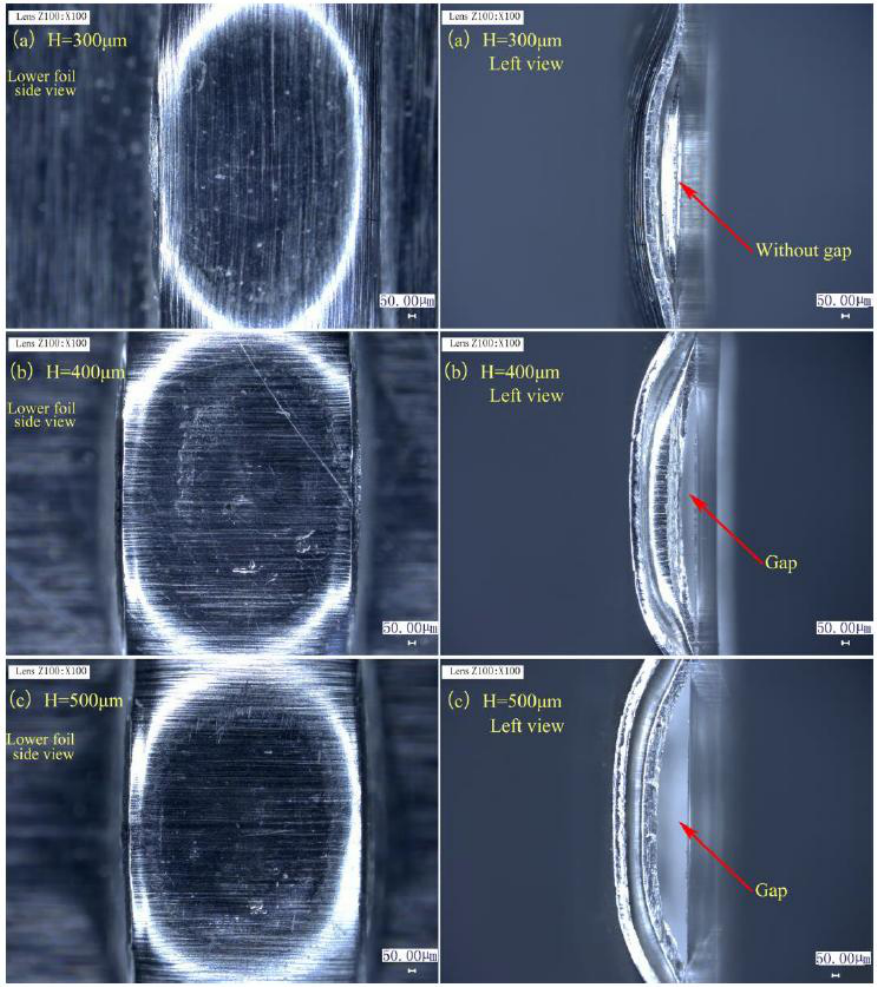
Figure 18. Preliminary joints produced under En 1 of 1690 mJ and three different H: ( a ) H = 300 μm; ( b ) H = 400 μm; ( c ) H = 500 μm.